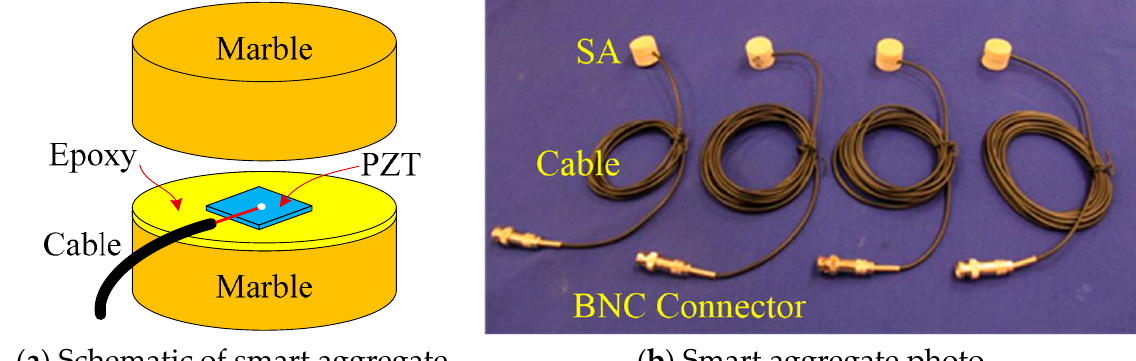
Figure 1. Piezoceramic-based smart aggregate.